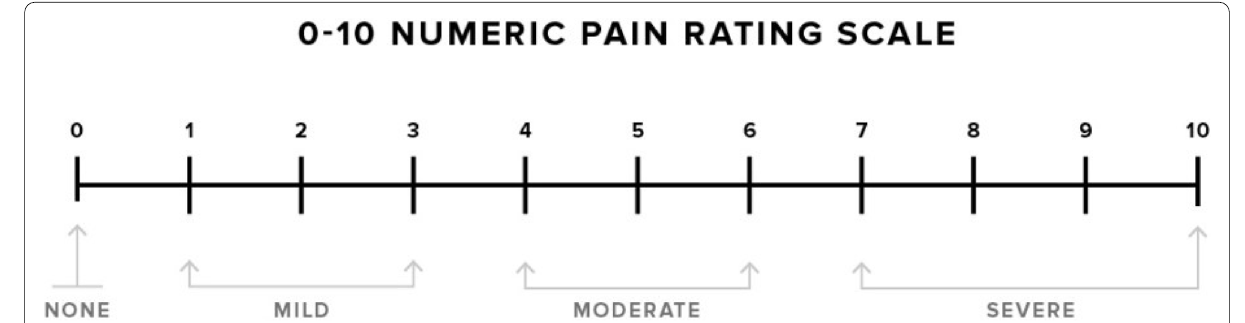
Fig. 2 The Numeric Pain Rating Scale